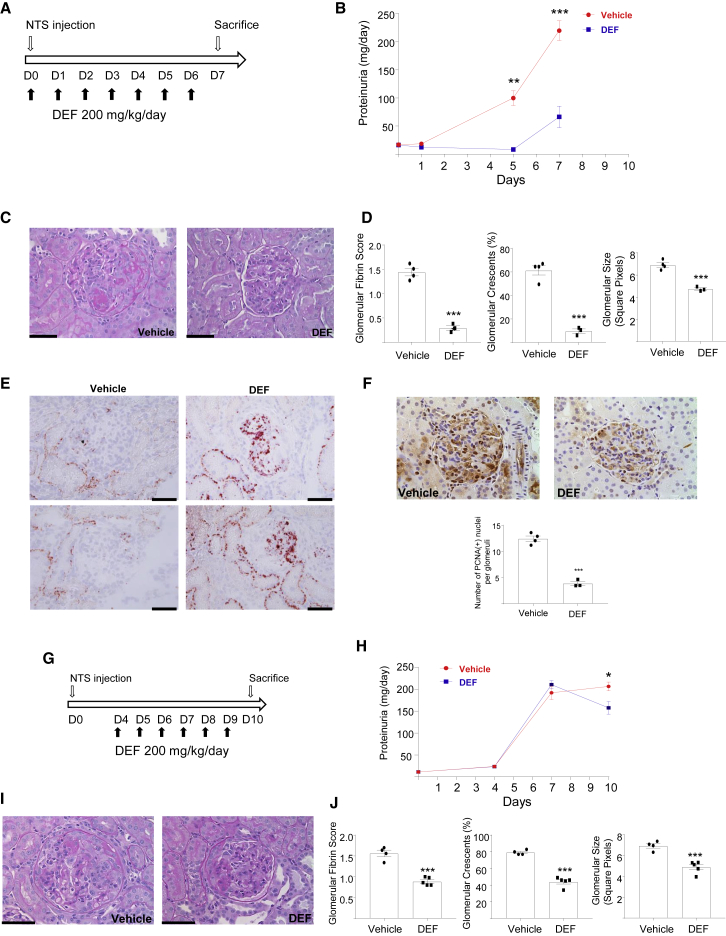
Acute Iron Deprivation Protects against Crescentic Glomerulonephritis and Induces De Novo Lipid Accumulation(A) Experimental design.(B) Amount of urinary protein at different time points during the course of NTN; n=3 or 4 rats/group.(C) PAS staining showing representative glomerular morphology of the vehicle (left) and the DEF (right) groups.(D) Glomerular fibrin score, percentage of glomeruli with crescents, and glomerular size in vehicle and DEF-treated rats; n = 3 or 4 rats/group.(E) Nephritic glomeruli of vehicle- or DEF-treated rats showing oil red O+ glomerular and tubular cells in the DEF group.(F) PCNA staining showing proliferating cells in nephritic glomeruli; number of nuclear PCNA(+) cells in the glomeruli (bottom); n = 3 or 4 rats/group.(G) Experimental design for the therapeutic experiment.(H) Amount of urinary protein levels at different time points during the course of NTN; n = 4 or 5 rats/group.(I) PAS staining showing representative glomerular morphology of the vehicle (left) and DEF (right) groups.(J) Glomerular fibrin score, percentage of glomeruli with crescents, and glomerular size in vehicle- and DEF-treated rats; n = 4 or 5 rats/group.∗p < 0.05, ∗∗p < 0.01, and ∗∗∗p < 0.001 by t test. Scale bars, 40 μm. Error bars represent SEM.See also Figure S6.